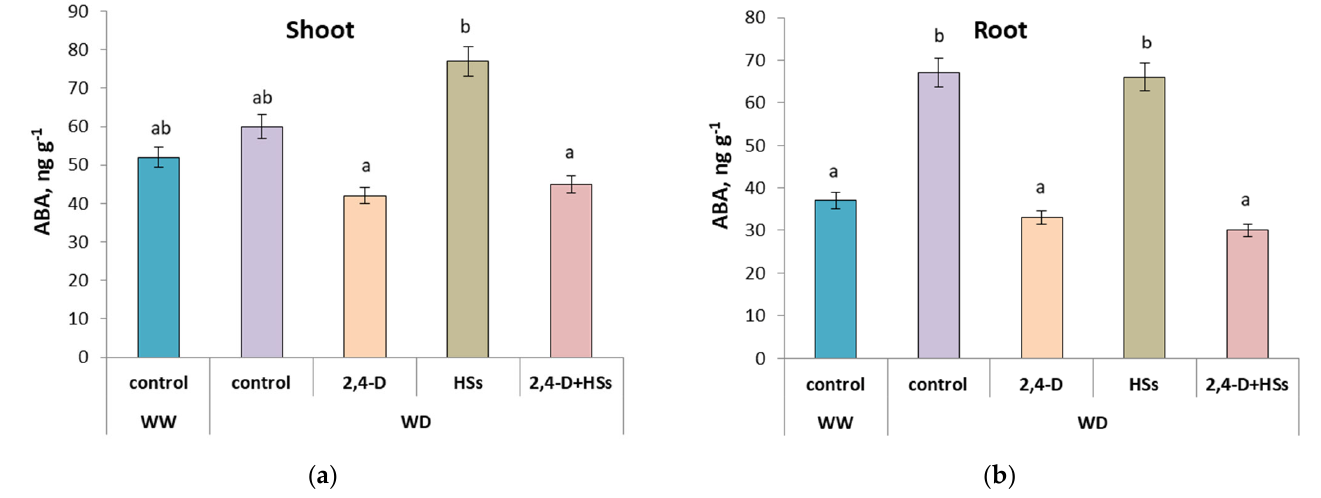
Figure 6. ABA concentration in shoots (a) and roots (b) of wheat plants 3 day after treatment with Pseudomonas plecoglossicida 2,4 ‐ D (2,4 ‐ D), humic substances (HSs) and their combinations (2,4 ‐ D + HSs) under well ‐ watering (WW) and in water deficit (WD) conditions. Statistically different means are marked with different letters, p ≤ 0.05, n = 9 (ANOVA followed by Duncan’s test). WD increased the concentration of cytokinins in the roots of all plants (Figure 7b,